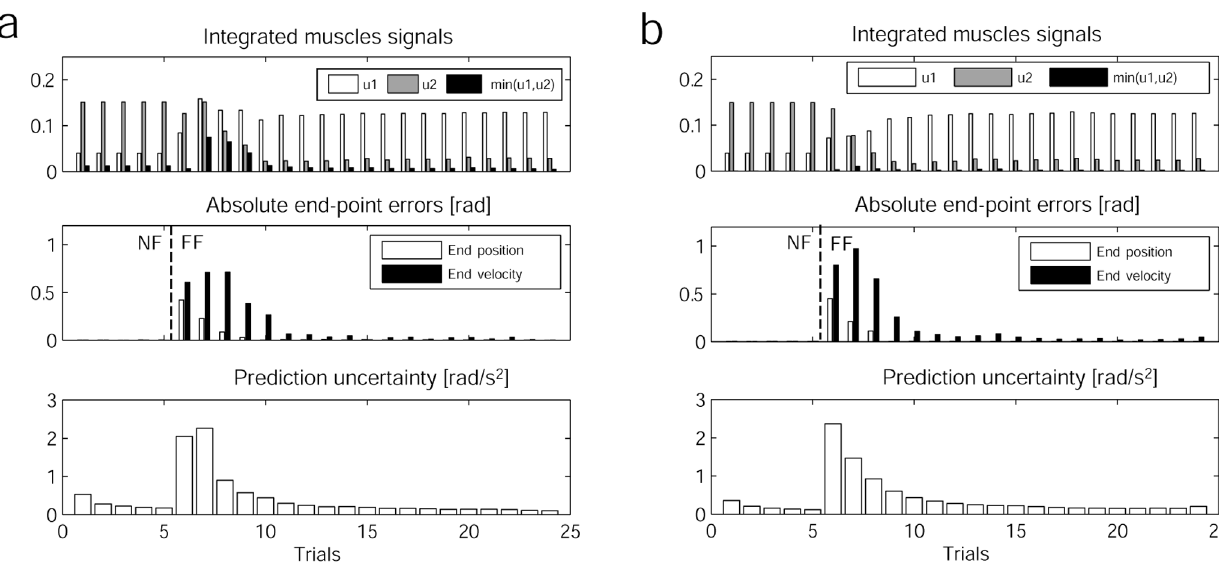
Figure 7. Adaptation results. (a) Accumulated statistics during 25 adaptation trials using stochastic OFC-LD. Trials 1 to 5 are performed in the NF condition. Top: Muscle activations and co-contraction integrated during 500ms reaches. Middle: Absolute joint errors and velocity errors at final time T =500 ms . Bottom: Integrated (internal model) prediction uncertainties along the current optimal trajectory, after this has been updated. (b) The same statistics for the adaptation using deterministic OFC-LD, meaning no uncertainty information is used for the optimization. This leads to no co- contraction and therefore worse reaching performance during adaptation.